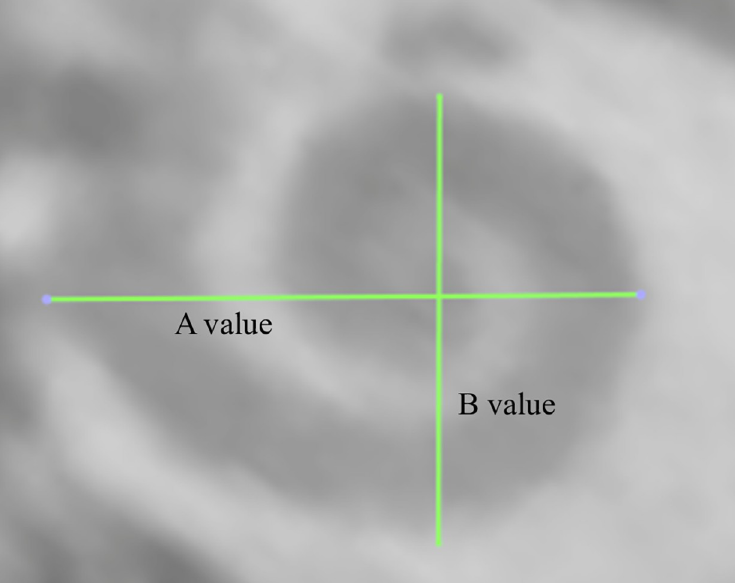
Fig 4. Measurement of global cochlea dimensions. Visualization of measurements of A (defined as the distance from the round window through the modiolus to the opposite wall of the cochlea) and B (maximal distance orthogonal to A).